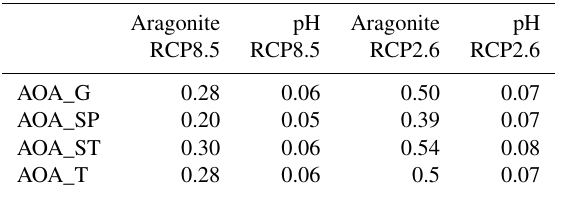
Table 2. The differences in surface value of aragonite saturation state and pH between the AOA experiments for each emission sce- narios in 2100 relative to the emissions scenario with no AOA. Aragonite pH